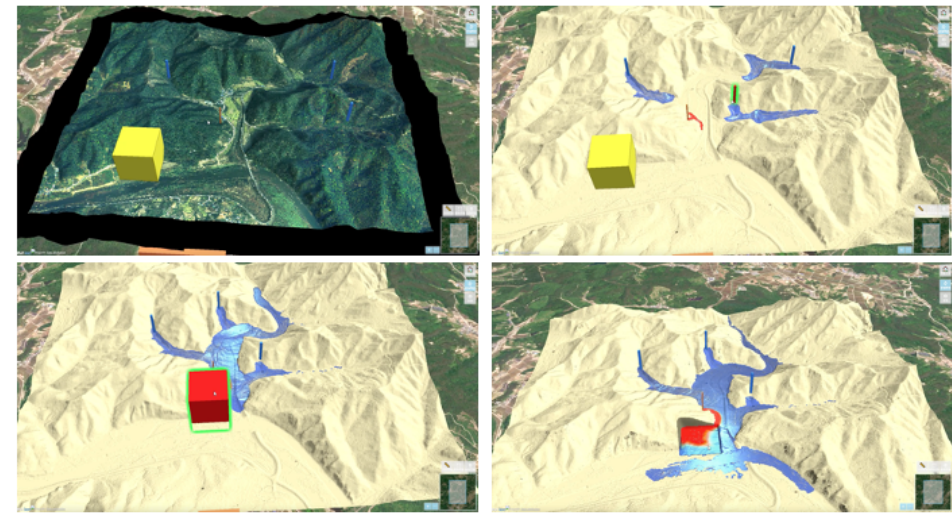
Figure 6. Flow of oil and wastewater based on the adjustment of geographical features.